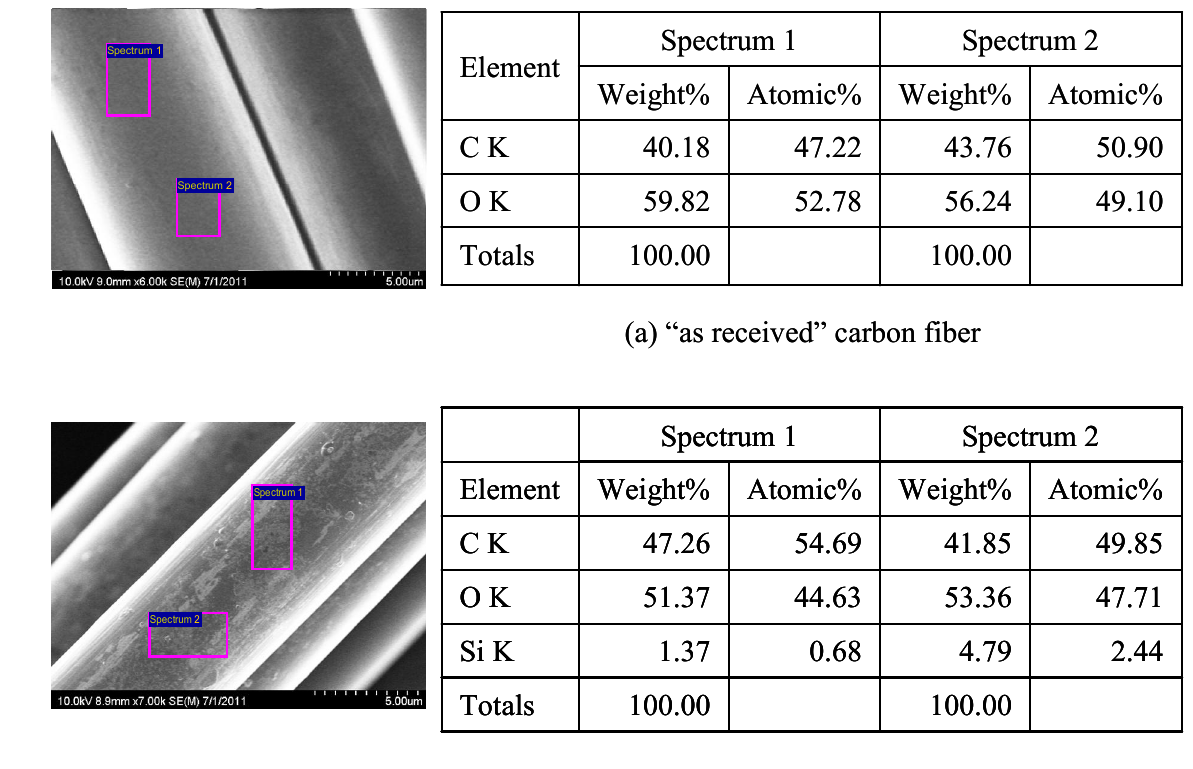
Figure 1. SEM images and EDS anaylsis of carbon fibers: ( a ) “as-received” and ( b ) POSS